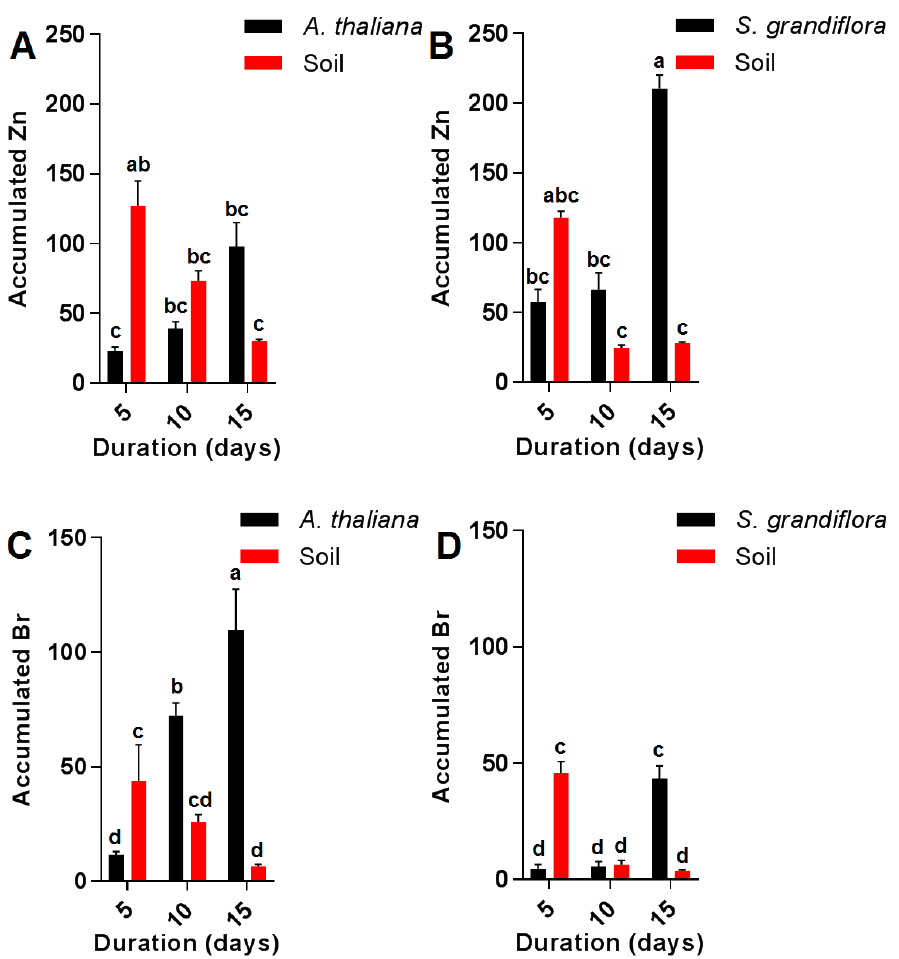
Figure 3. Accumulated Zn (A and B), and Br (C and D) in CYP4502E1 expressing A. thaliana and S. grandiflora plants and in the soil during 15 days in soils contaminated with Zn (41.9 ppm) and Br (51.3